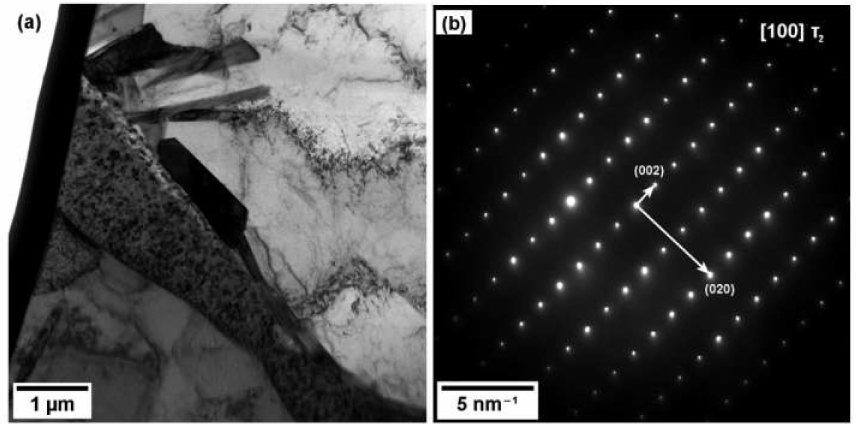
Figure 10. ( a ) BF TEM micrograph of the precipitate at the interface. ( b ) SAED of the dark particle in ( a ) corresponding to the τ 2 phase in [100] direction.